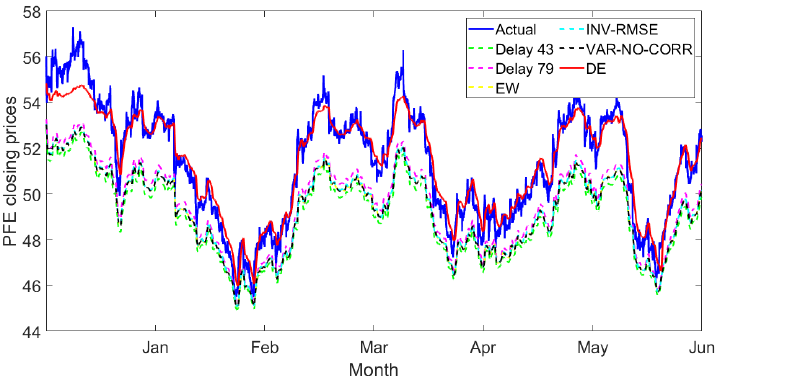
Figure 18. The forecasting curve for actual data versus the individual and combination methods of PFE stock obtained from LSTM model between January and June